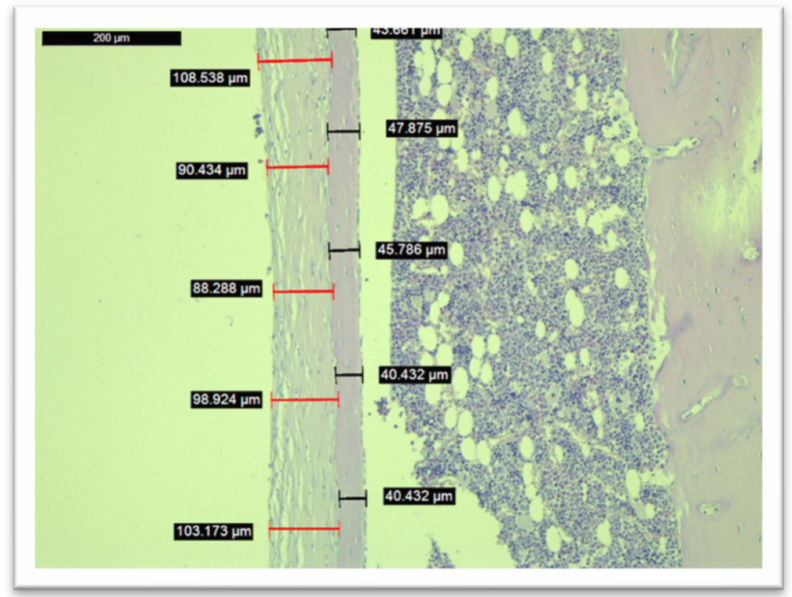
Figure 7. Histological measurements of cortical bone tissue and fibrous tissue in the peri-implant site within Group III